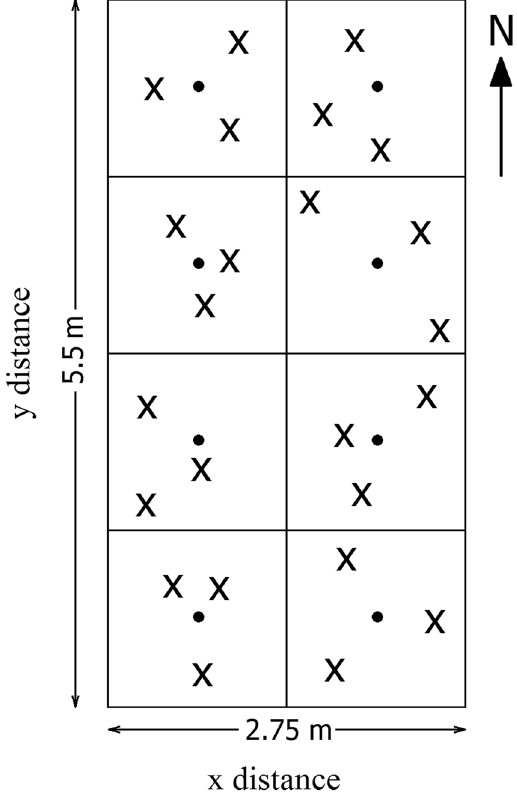
Figure 1. Illustration of a clustered random sampling design within a plot in the three-year long fertilization experimental site at the Tennessee State University (TSU) Agricultural Research Center in Nashville, TN, USA. Filled circles represent centroids (n = 8) and each plot consists of eight centroids with one in each sampling region (1.375 × 1.375 m). Xs represent sample locations determined from random directions and distances from a centroid. The extent of an interpolation map was thus determined by the minimum and maximum values at horizontal and vertical axes, and each map can attain its extent less than or equivalent to the study area (2.75 × 5.5 m